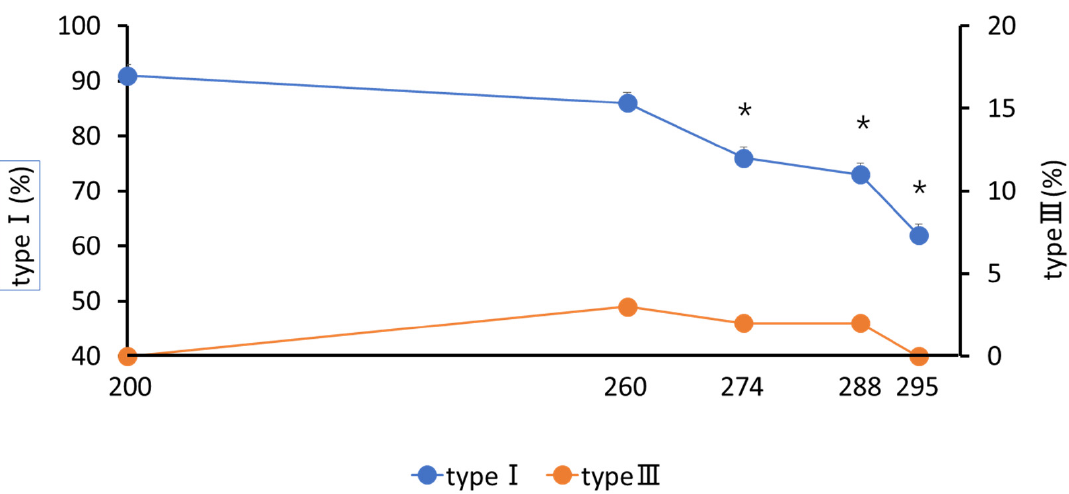
Figure 5. Changes in the percentage of cervical tissue type I and type III collagen with days of pregnancy. * p < 0.05 compared with 200 days in type I.